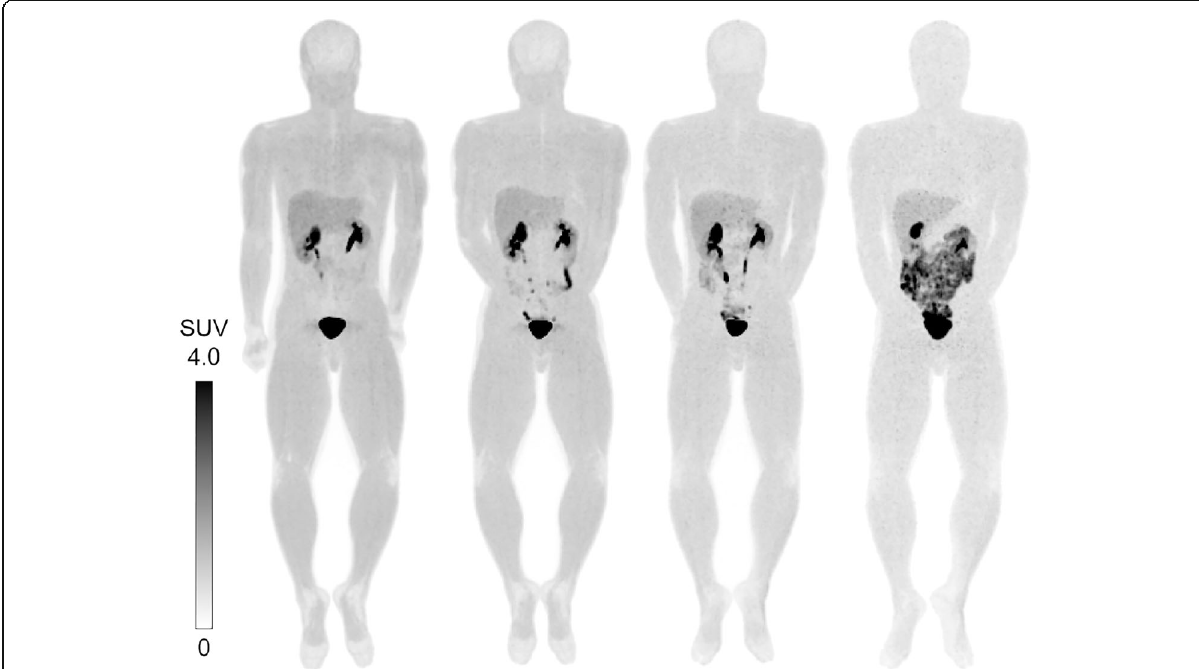
Fig. 3 MIP images of [ 18 F]DiFA in a healthy volunteer. Decay-corrected anterior maximum-intensity projections of PET at 1, 2, 4, and 6 h (from left to right) after an injection of 718.7MBq of [ 18 F]DiFA in a 74.0-kg male volunteer. There was a rapid clearance of activity in the kidneys, liver, and bladder. Gallbladder activity peaked following the first meal after the PET acquisition at 4 h, then decreased with time